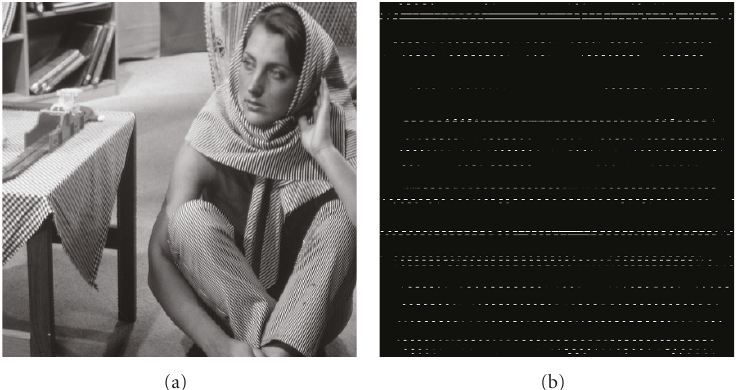
Figure 2: (a) Watermarked Barbara Image, (b) 1000 times magnified di ff erence between the original and the watermarked Barbara images.